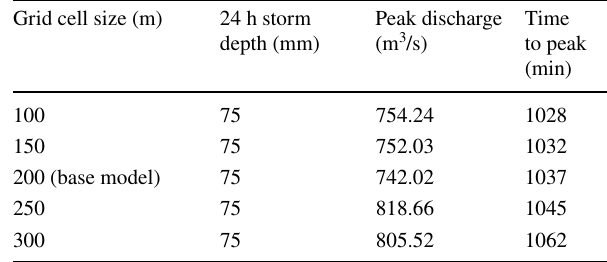
Table 12 Flood properties of calibrated GSSHA base model for